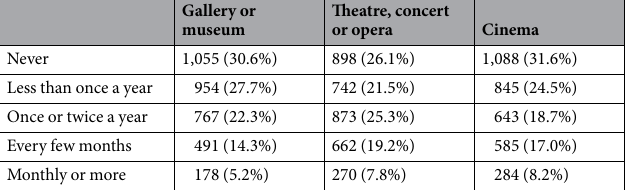
Table 1. Cultural